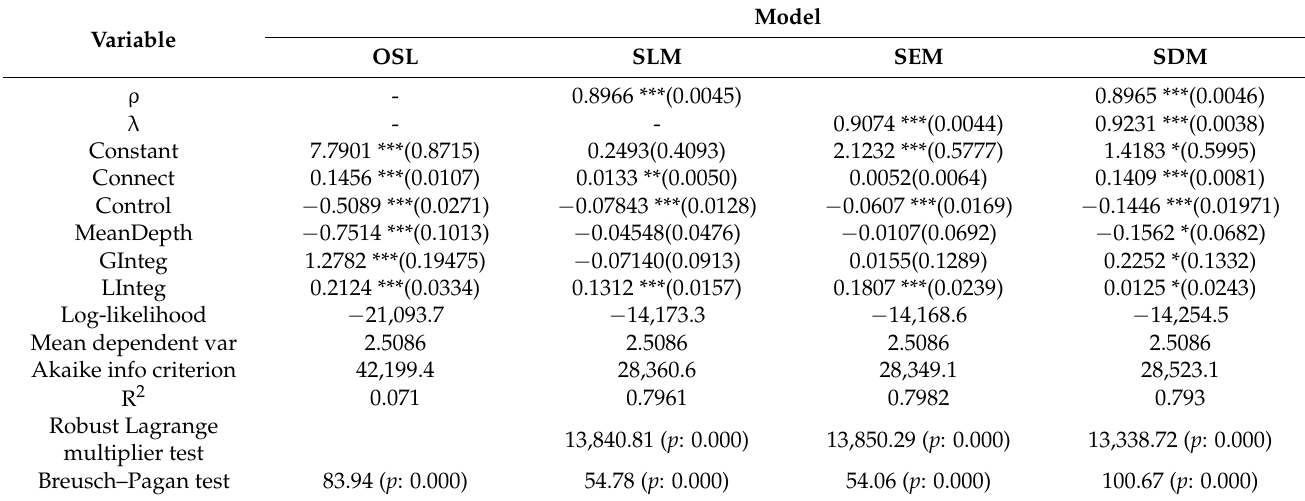
Table 5. Weekend Spatial Autocorrelation Regression